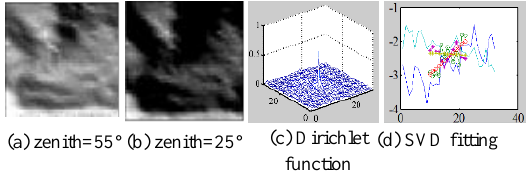
Figure 5. Disparity estimation from a pair of images with different zenith angles using PC-Delta-function and SVD-PC in a small matching window.